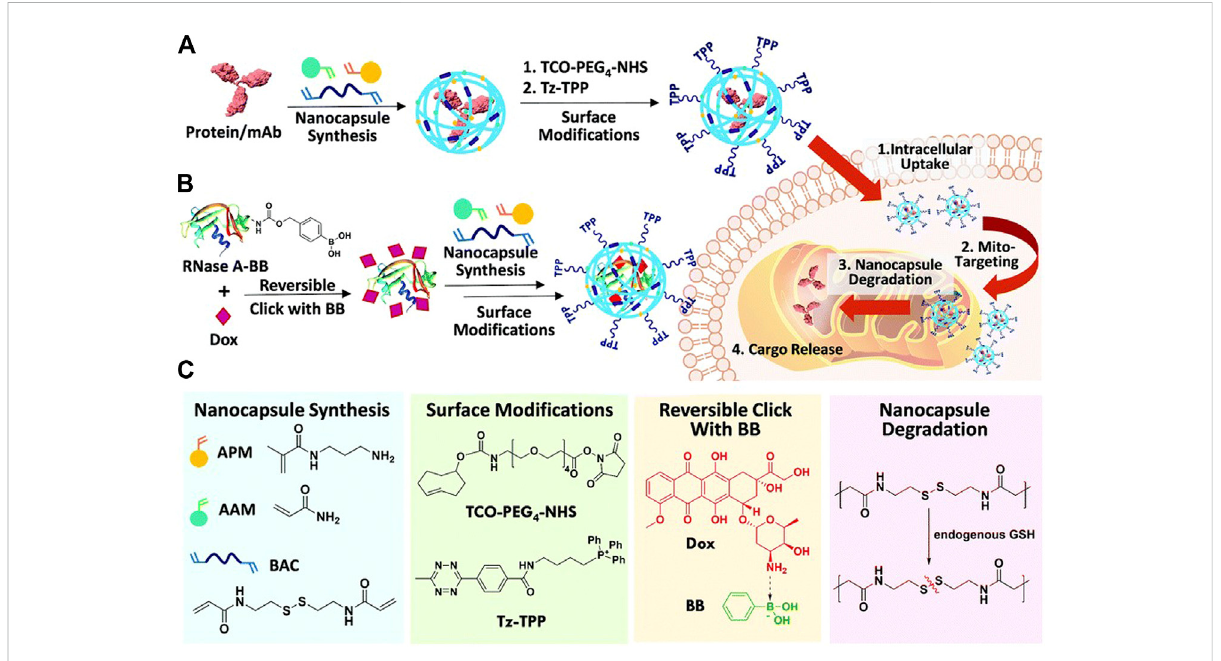
FIGURE 3 (A) Scheme summarizing the preparation of TPP – modi fi ed protein nanocapsules, intracellular uptake, TPP-directed mitochondrial accumulation, mitochondria GSH-triggered cargo release, and fi nally target binding/engagement. (B) Scheme showing co-encapsulation of phenyl boronic acid (BB)-modi fi ed RNase A/Doxorubicin (Dox) in a dual-cargo nanocapsule. (C) Chemical structures of reagents used. Reproduced with permission from Ref. (Liew et al.,